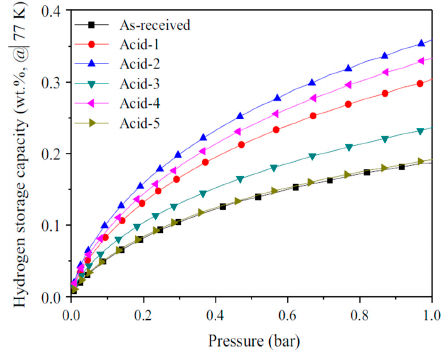
Figure 4. Hydrogen adsorption capacities of p-type MWCNTs with different acid-mixed treatments, where Acid-1 is H 2 SO 4 , Acid-2 is H 2 SO 4 :H 2 O 2 = 3:1, Acid-3 is H 2 SO 4 :H 2 O 2 = 1:1, Acid-4 is H 2 SO 4 :H 2 O 2 = 1:3, Acid-5 is H 2 O 2 [80] .